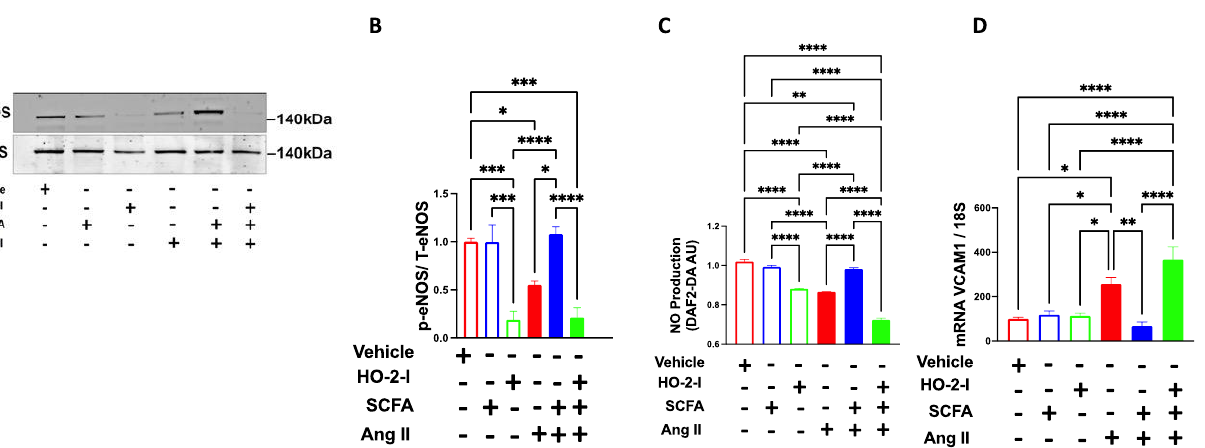
Figure 2. SCFAs rescue Ang-II-induced eNOS reduction through HO-2. Immunoblots ( A ) and quantification ( B ), NO production assay ( C ), and qPCR for VCAM1 ( D ) showing that the Ang-II- induced reductions in eNOS expression and NO production and increased VCAM1 expression in brain microvascular endothelial cells were reversed by the SCFAs/HO-2 axis. * p < 0.05; ** p < 0.01; *** p < 0.001; **** p < 0.0001. N = 3–7. SCFAs: short-chain fatty acids; Ang II: angiotensin II; HO-2 I: heme oxygenase 2 inhibitor; eNOS: nitric oxide synthase; NO: nitric oxide; and VCAM1: vascular cell adhesion molecule.